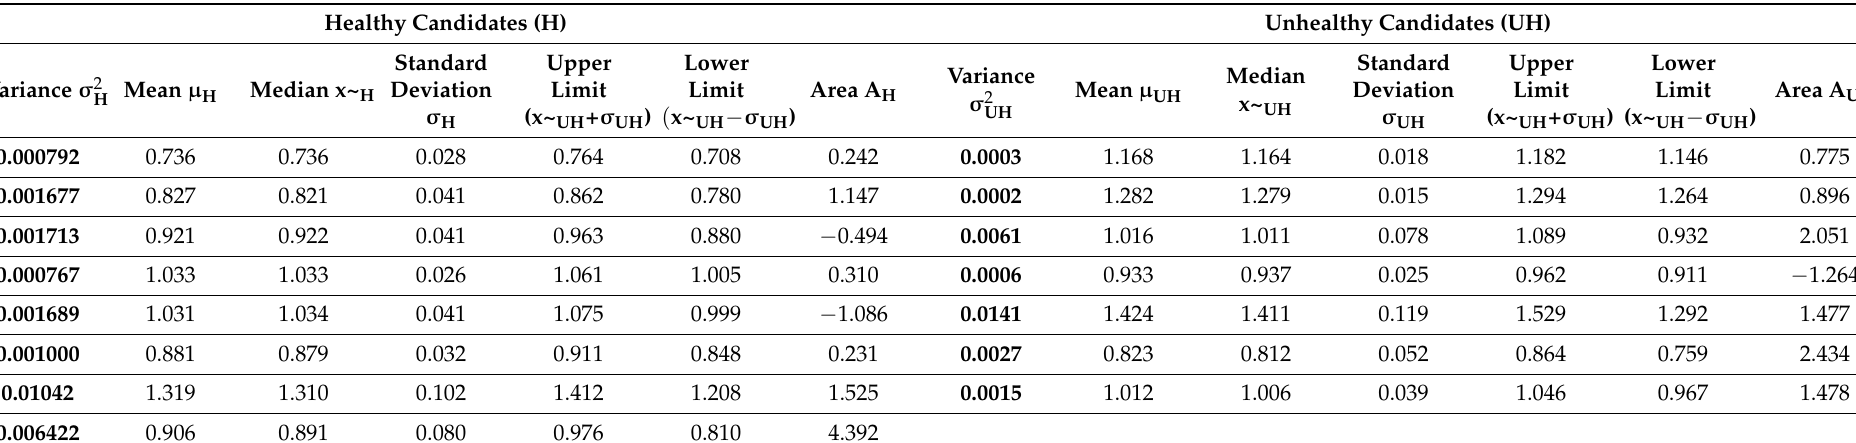
Table 4. Statistical analysis outcome for the combination of parameters RR interval, JT interval, and QRS